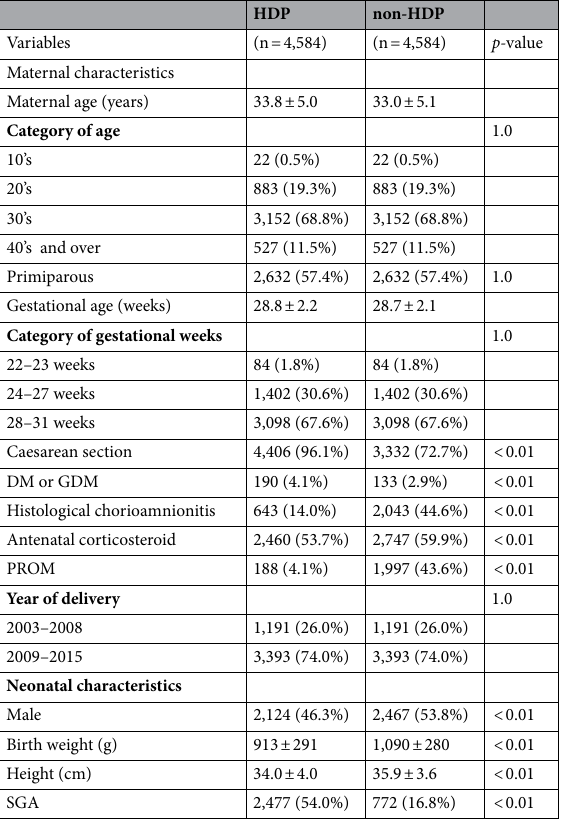
Table 1. Baseline characteristics after 1:1 stratification matching in the HDP and non-HDP groups. Data are given as mean ± standard deviation for continuous variables and n (%) for categorical variables.